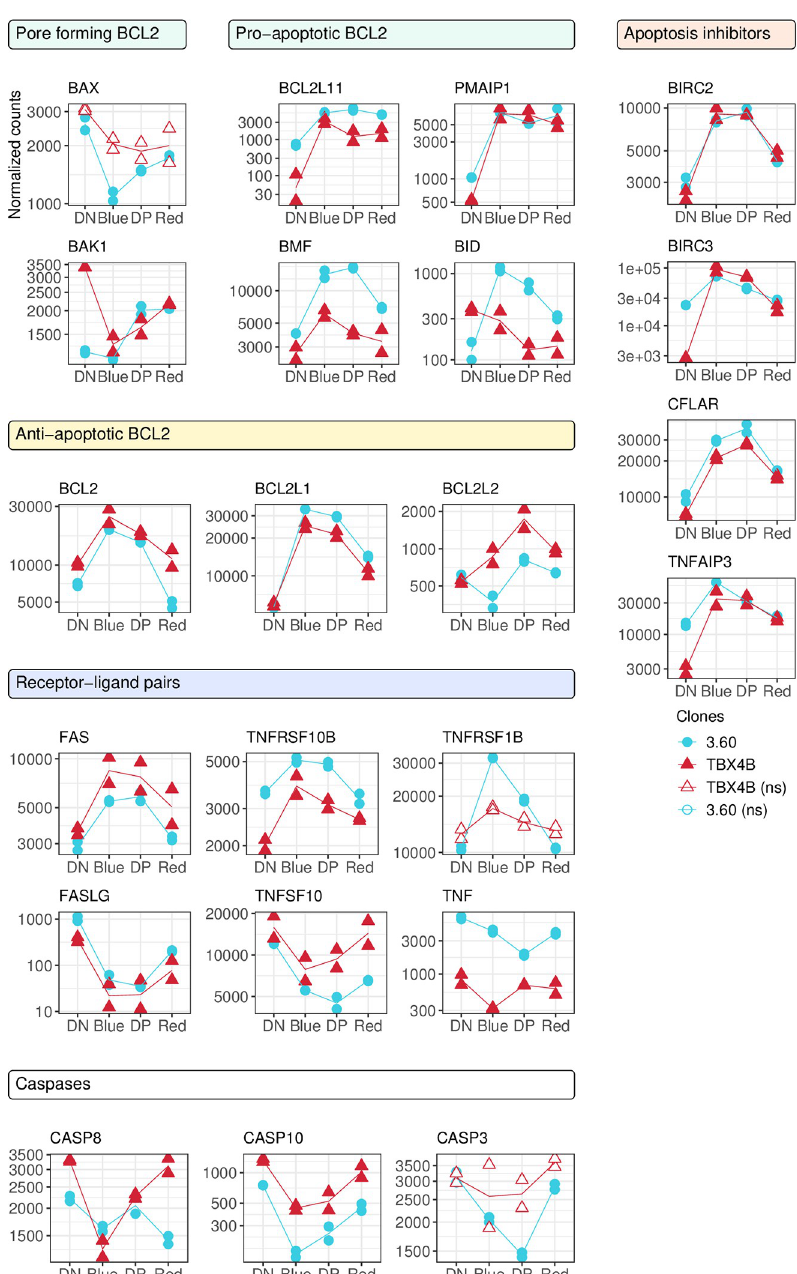
Fig 6. Temporal patterns of pro- and anti-apoptotic factors. Gene expression trajectories of anti- and pro-apoptotic BCL2 family members, extrinsic apoptosis factors, anti-apoptotic and caspase genes. Y-axis: normalized counts on log 10 -scale. Statistical significance was determined by LRT. FDR-corrected p-value < 0.01; ns—not